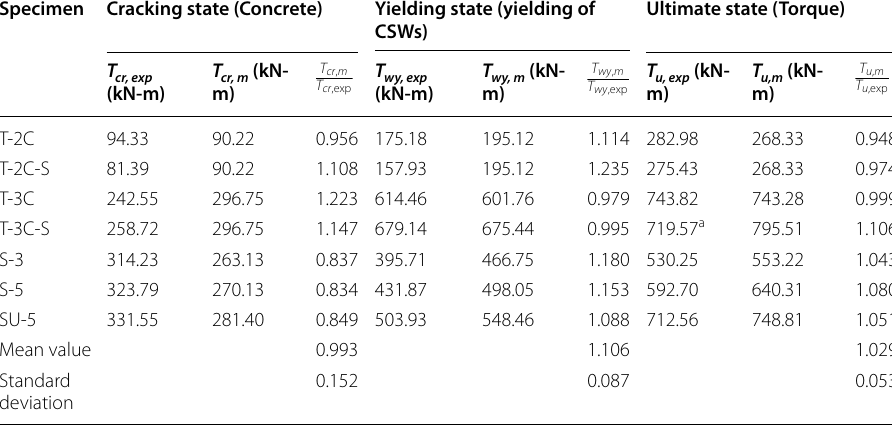
Note that: exp represents the experimental results; m represents the predicted values from the USMMT a Due to the limitation of test methods, T-3C-S may not actually reach the ultimate torque